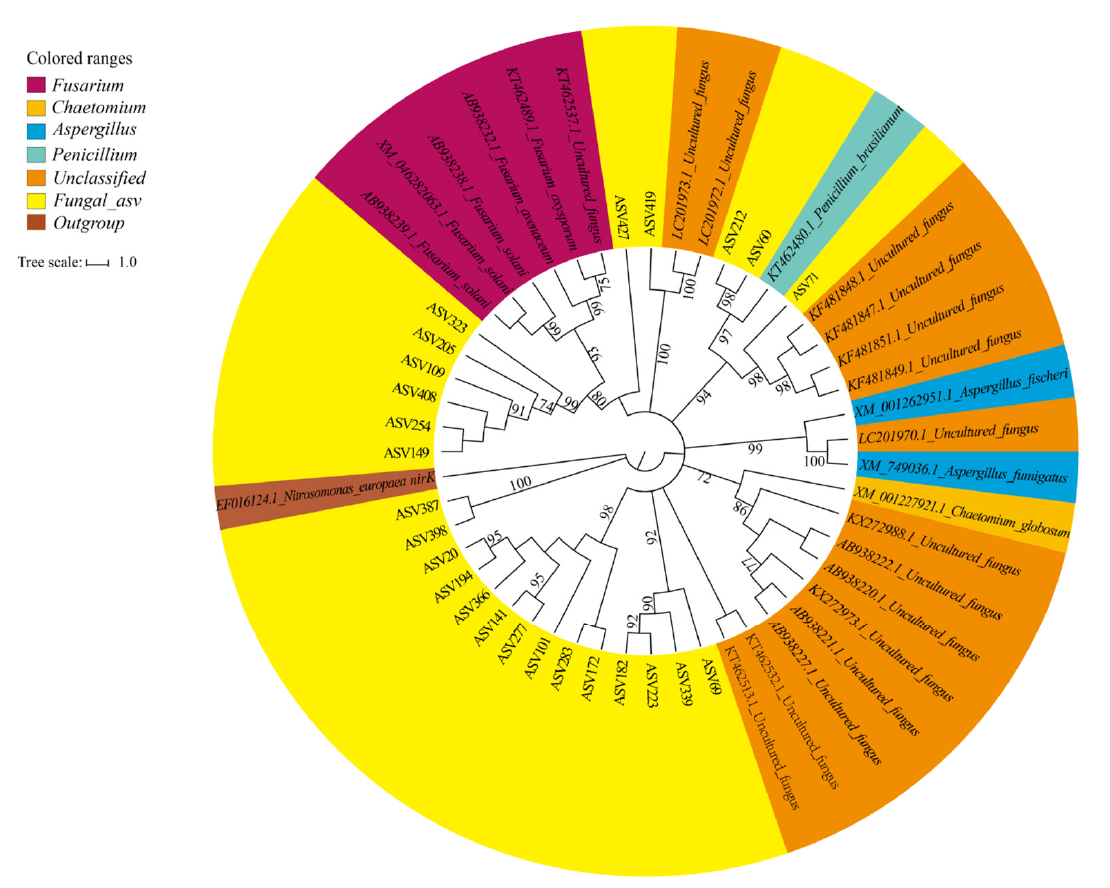
Figure 6. Maximum likelihood phylogenetic tree depicting the top 25 Fungi nirK OTUs, along with relevant reference sequences from NCBI databases. The analysis employed the Nitrosomonas europaea nirK as the outgroup and MAGE11.0 software for sequence alignment. The resulting dendrogram was built using a tree map derived from maximum likelihood inference, with 1000 Ultrafast bootstrap and guidance value of 0.70.